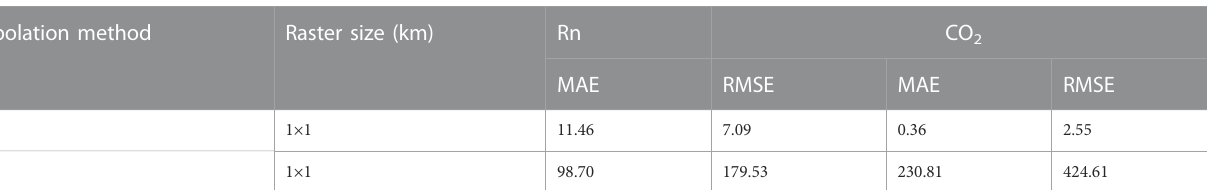
TABLE 3 Evaluation of spatial interpolation